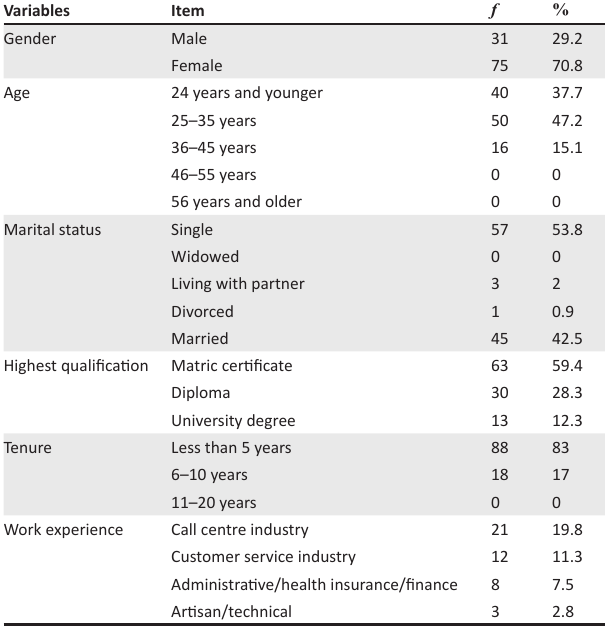
TABLE 1: Characteristics of participants ( N =